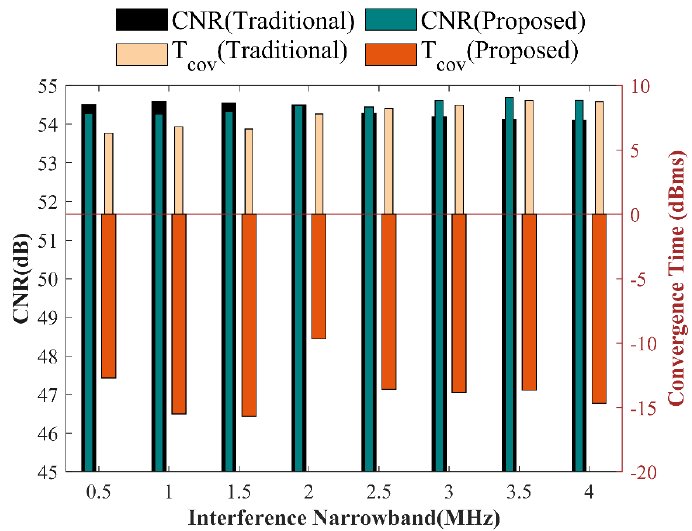
Figure 12. Performance comparison under scenarios with different interference bandwidth.